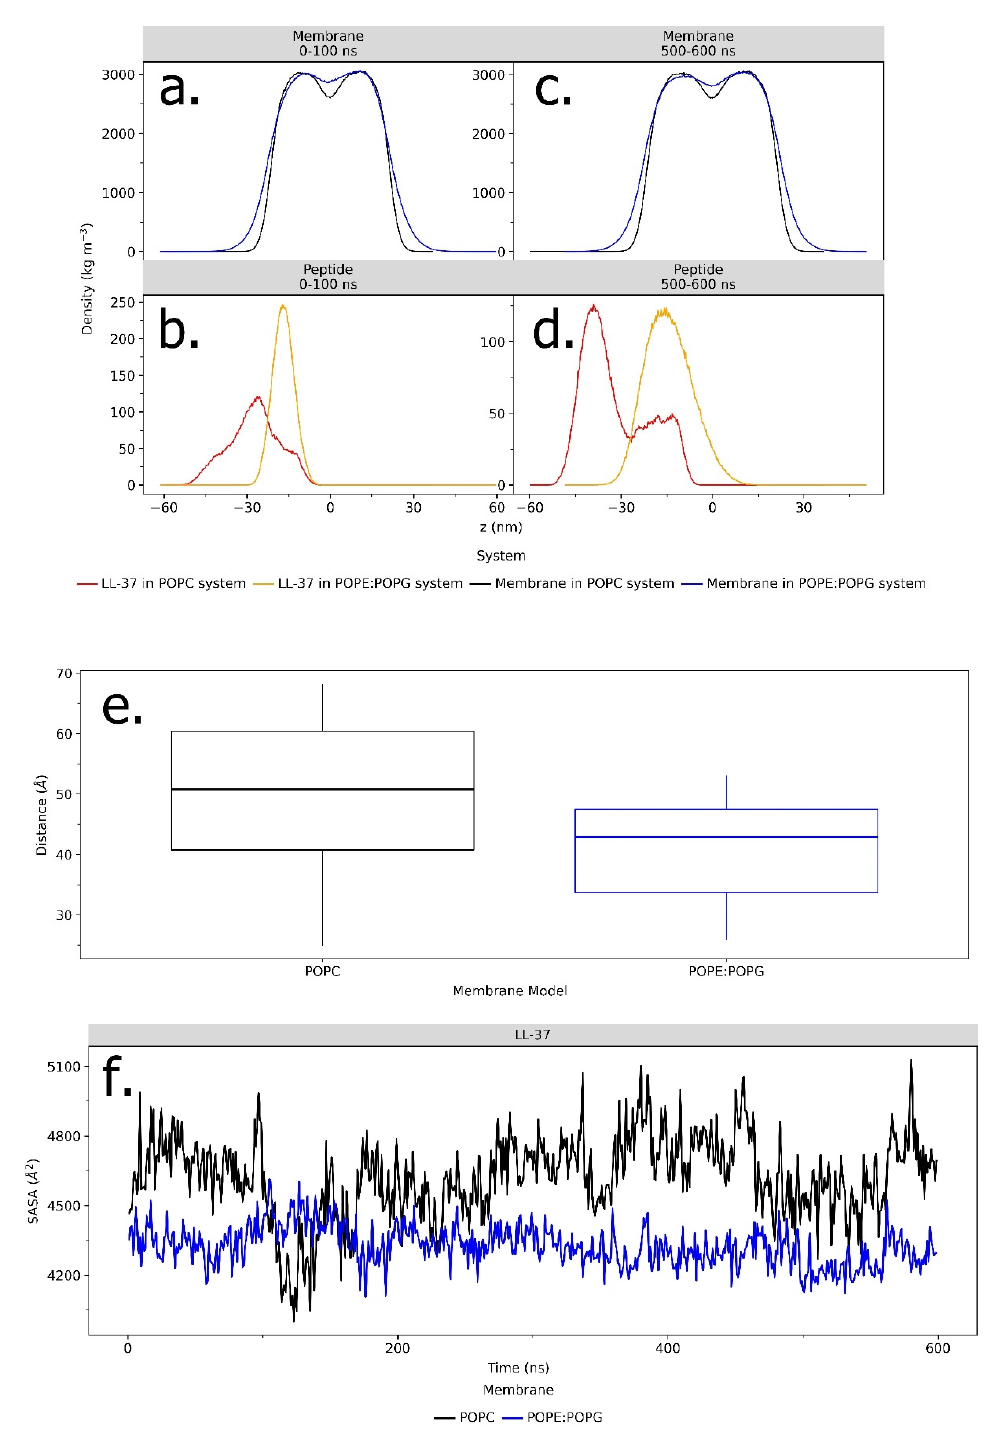
Figure 6. Electron density profiles of LL-37 with the POPC (black) and POPE:POPG (blue) membranes at the initial position and after 600 ns of simulation ( a – d ). The average distance (Å) between LL-37 and the center of the POPG and POPC bilayer membranes calculated using cpptraj program in Amber20 ( e ). The SASA (Å2) fluctuation of LL-37 in POPC and POPE:POPG membrane systems during the 600 ns simulation ( f ). The data were calculated using NAMD analysis from VMD.